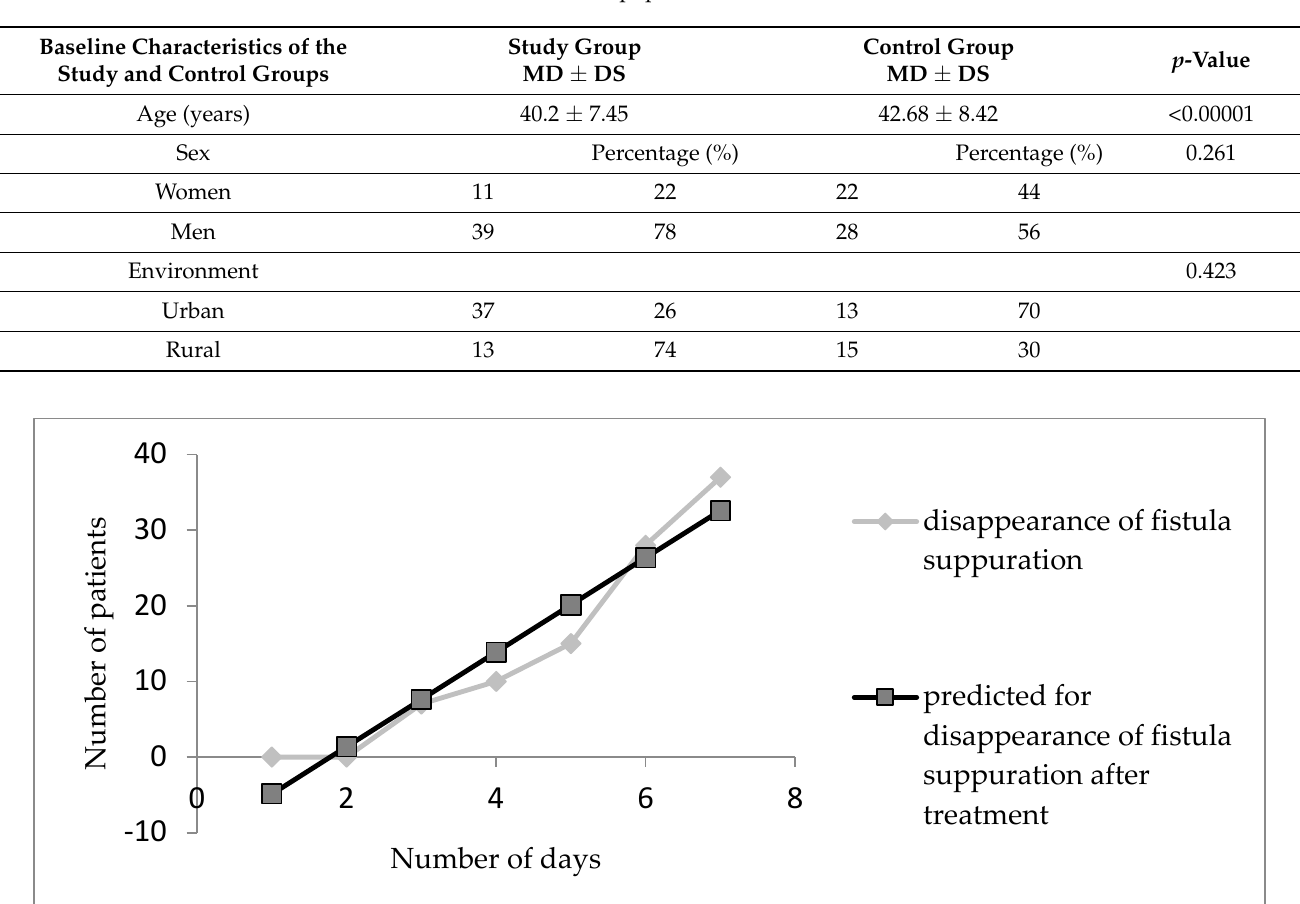
Table 1. Characteristics of the population.